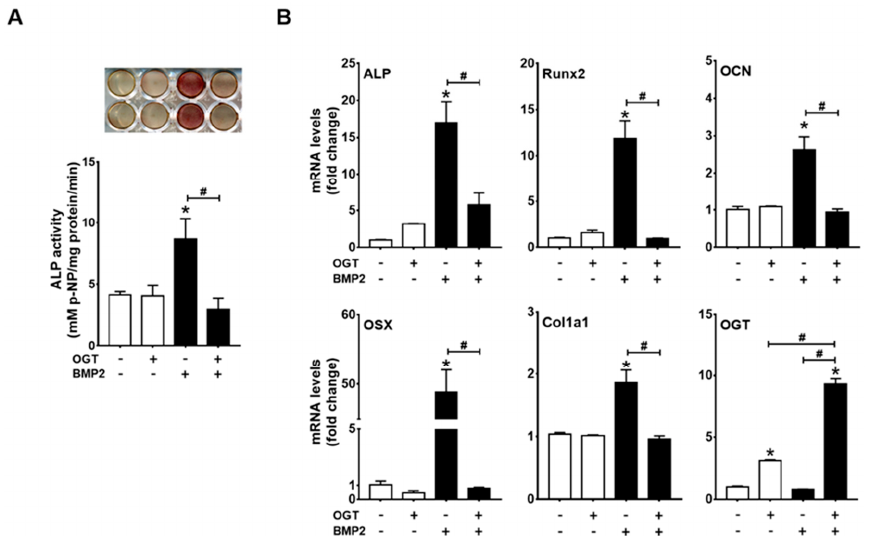
Figure 3. OGT overexpression inhibited osteogenic differentiation of C2C12 cells. C2C12 cells were transfected with OGT expression plasmids and incubated in the presence or absence of BMP2 for 48 h. Subsequently, ALP staining and ALP activity assays ( A ) as well as qRT-PCR analysis ( B ) were performed to examine osteogenic differentiation. * p < 0.05 compared with the non-treatment control; # p < 0.05 for the indicated pairs. Int. J. Mol. Sci. 2018 , 19 , 202